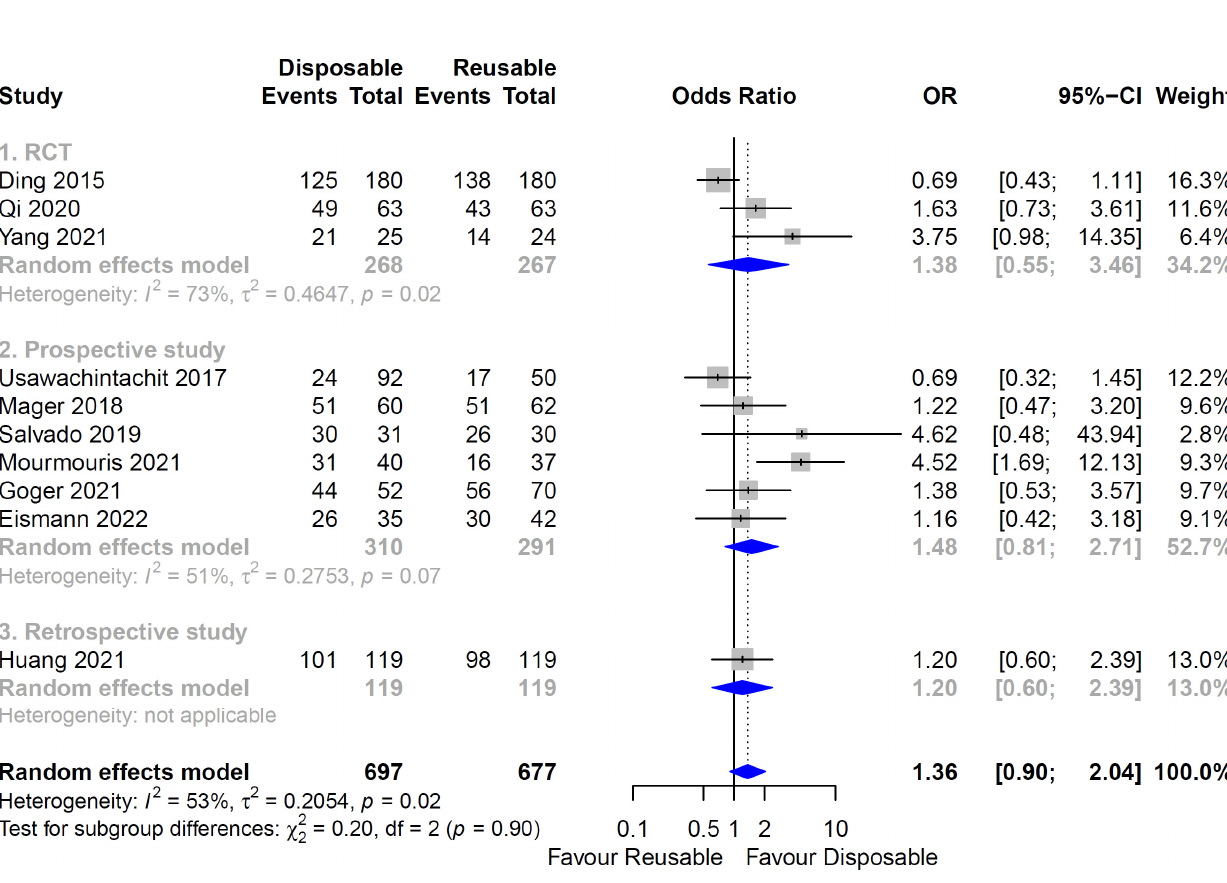
Figure 3. Forest plot for stone-free rate (SFR) of disposable and reusable flexible ureteroscopic stone surgeries (fURS) in each study design. (1) SFR of disposable and reusable fURS in randomized clinical trials (RCTs). (2) SFR of disposable and reusable fURS in prospective studies. (3) SFR of disposable and reusable fURS in retrospective study. Study design is written in gray above each analysis (RCT, prospective study, retrospective study). The heterogeneity of each analysis and the applied model are written in gray below each analysis. The heterogeneity between subgroups and the applied model are written in black at the bottom [17–26].